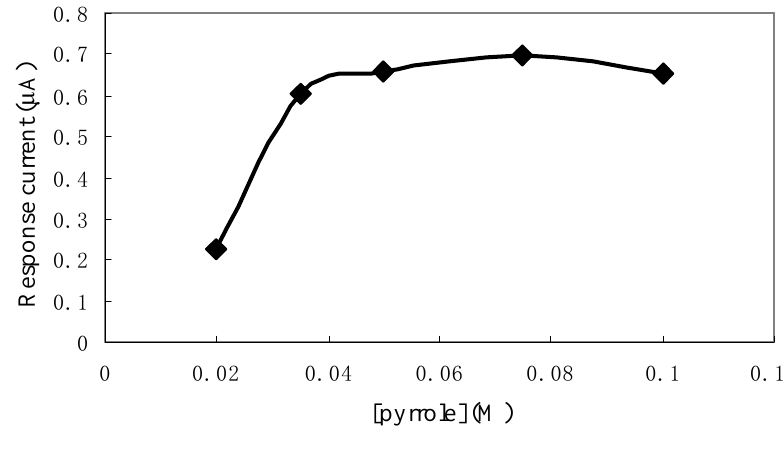
Figure 2. Effect of pyrrole concentration on response current to 1 mM H O (1 µ L, -300 mV potential 2 2